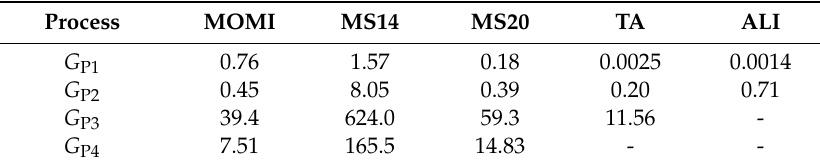
Table 5. ITSE criterion values for disturbance-rejection.